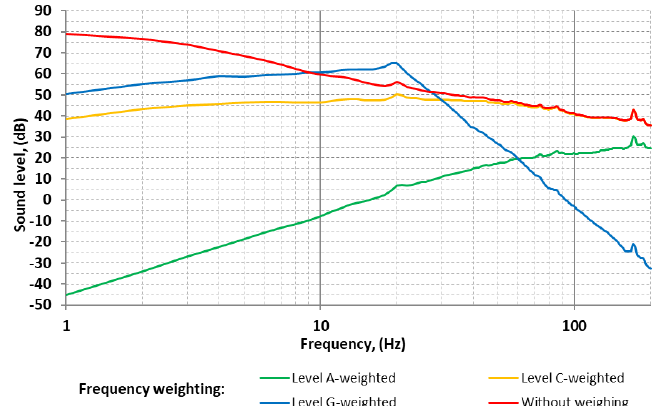
Figure 4. Courses of noise spectra generated by T1 turbine by application of various weighting curves.